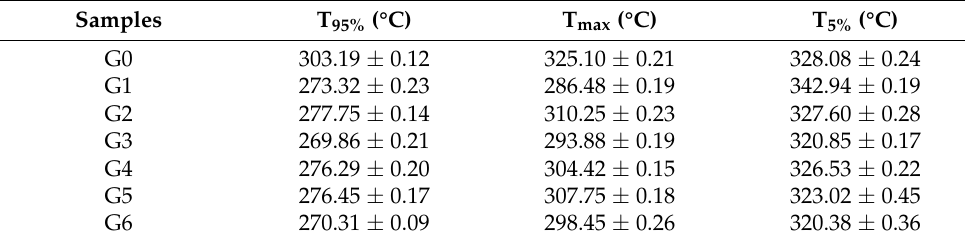
Figure 7. Thermogravimetric curves ( a ): TG curves, ( b ): DTG curves) of PLA, PPC, PLA/PPC and PLA/PPC/PLA-g-GMA blends (G0: PLA; G1: PPC; G2 PLA/PPC; G3: PLA/PPC/PLA-g-GMA; G4: PLA/PPC/PLA-g-GMA/St; G5: PLA/PPC/PLA-g-GMA/AMS; G6: PLA/PPC/PLA-g-GMA/EP). Table 7. Thermogravimetry data of PLA, PPC, PLA/PPC and the PLA/PPC/PLA-g-GMA blends. Samples T 95% (°C)